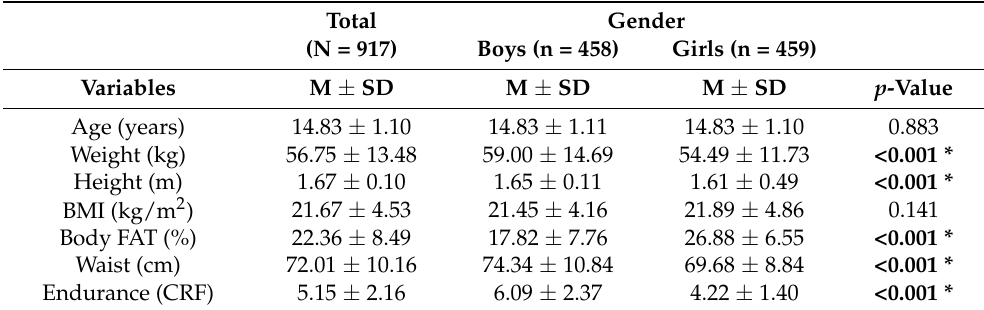
Table 1. Anthropometric characteristics and endurance parameters (N = 917).